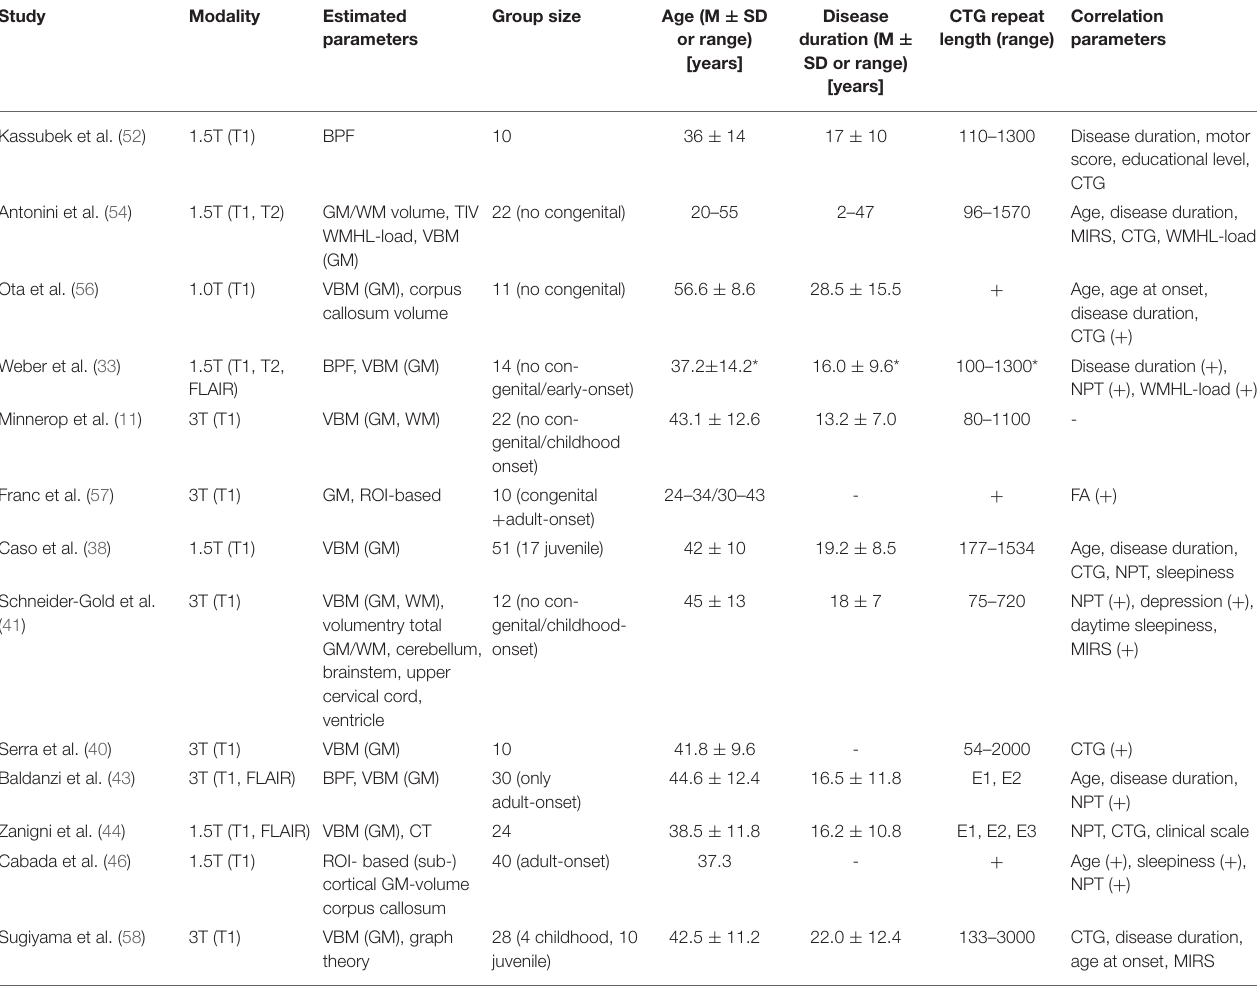
TABLE 1 | Quantification of brain volume in